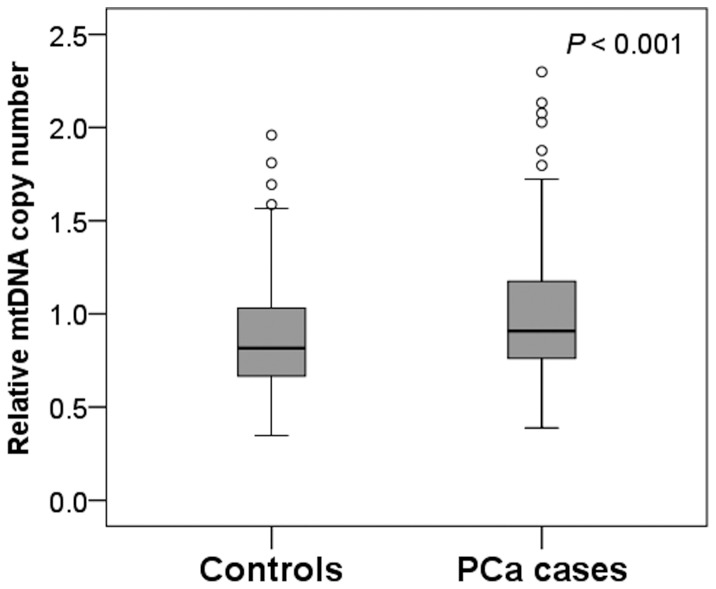
Distribution of peripheral blood mtDNA copy number in Han Chinese patients with prostate cancer and healthy controls.The box plots describe the median (solid line across the box), inter-quartile range and outliers (circles outside the ends of whiskers) for each study group. The P-value is from a comparison of mtDNA copy number distribution between cases and controls using the Mann Whitney U test.